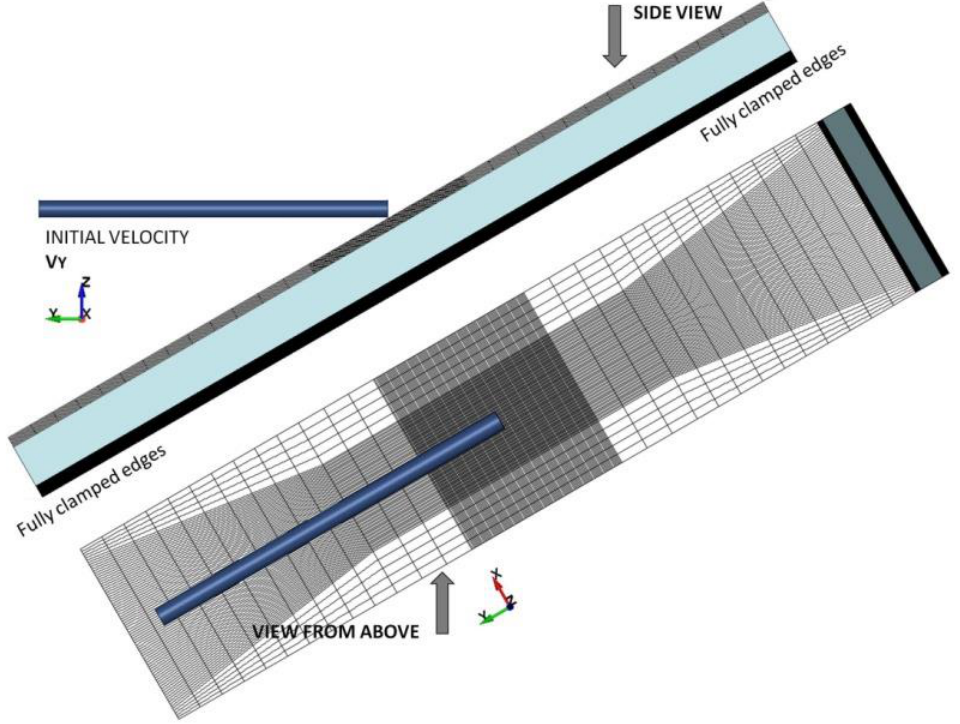
Figure 7. Numerical representation of the steel-elastomer passive armour.